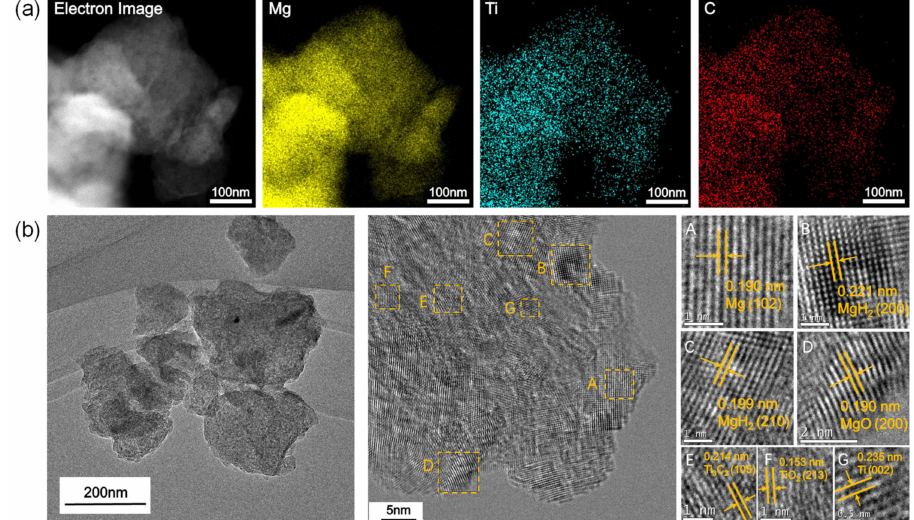
Figure 7. ( a ) Electron image and corresponding elemental mappings of MgH 2 -6 wt.% ML-Ti 3 C 2 after ball milling, and ( b ) TEM and HRTEM images of the as-milled MgH 2 -6 wt.% ML-Ti 3 C 2 (A–G: Subfigures of the middle image of Figure 2. ( b ) and corresponding interplanar